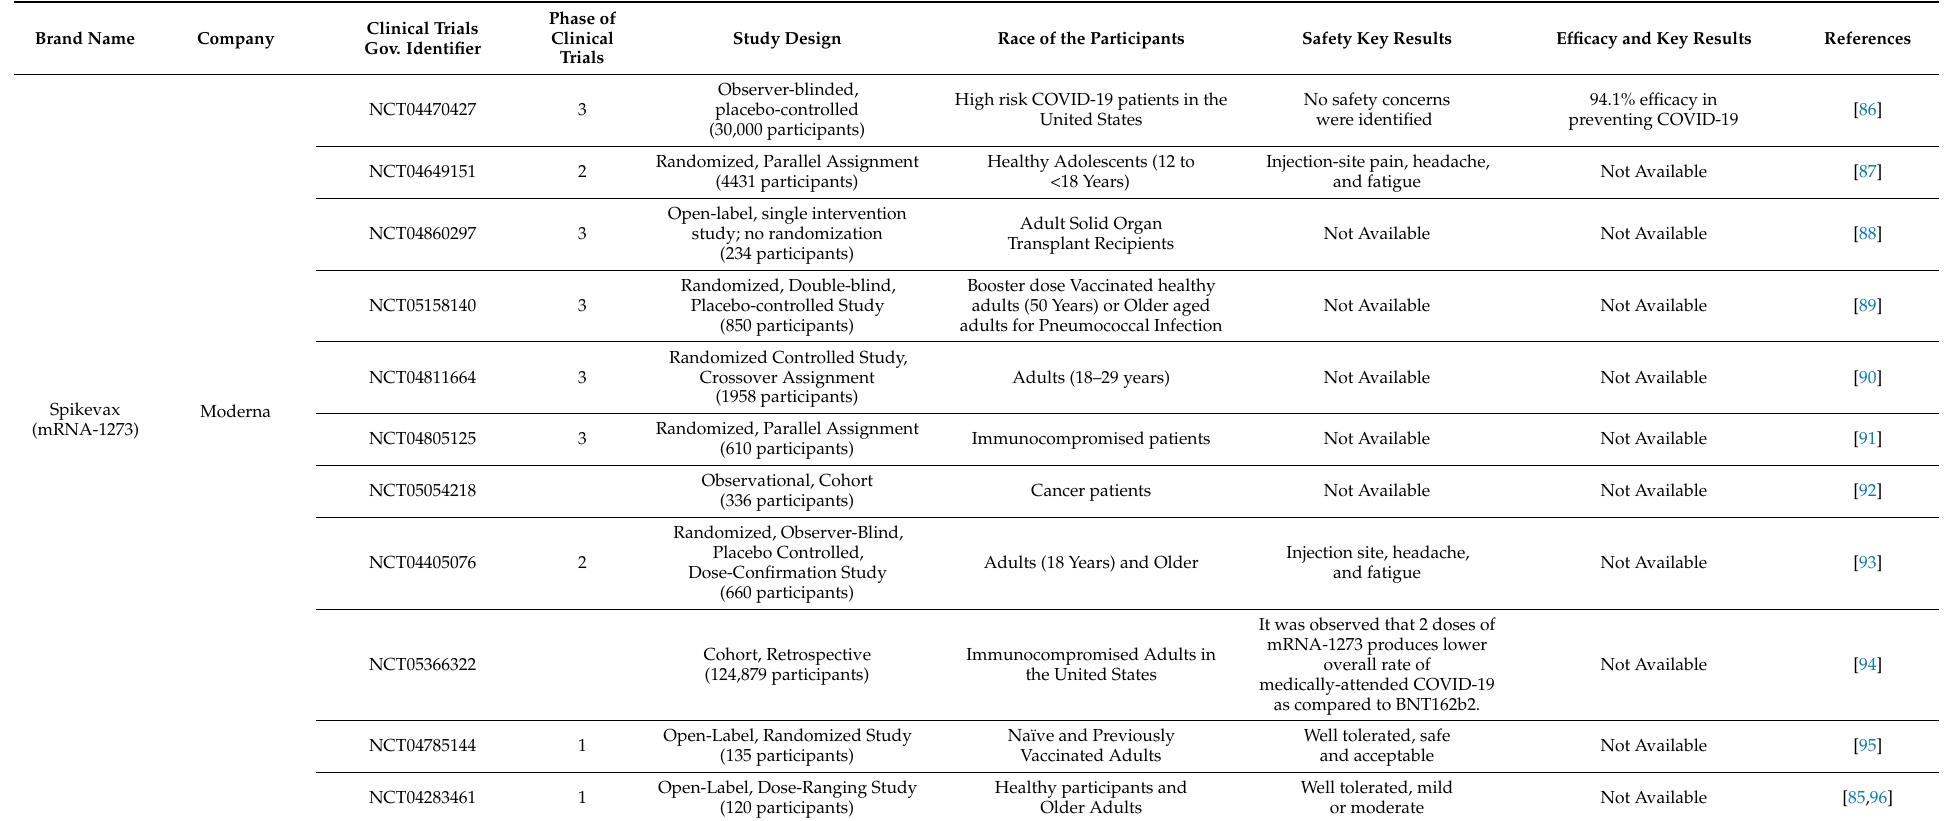
Table 4. Safety and efficacy studies of mRNA vaccines in clinical